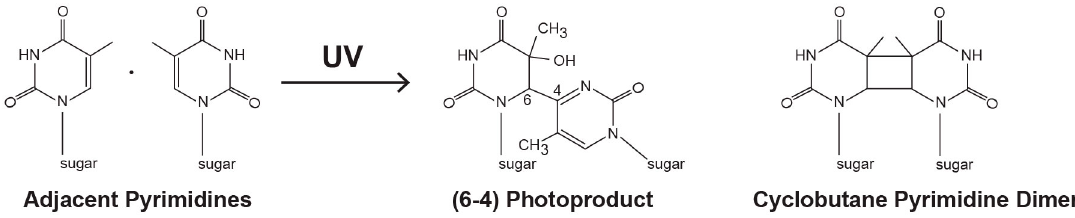
Figure 1. UV-induced photoproduct formation in DNA. The absorption of UV photons of light by adjacent pyrimidine nucleotides in DNA generates two major photoproducts, the pyrimidine (6-4) pyrimidone photoproduct [(6-4)PP] and the cyclobutane pyrimidine dimer (CPD). Though photoproduct formation between adjacent thymines is shown, (6-4)PPs and CPDs can also form to varying extents between adjacent cytosines and between cytosines and thymines.